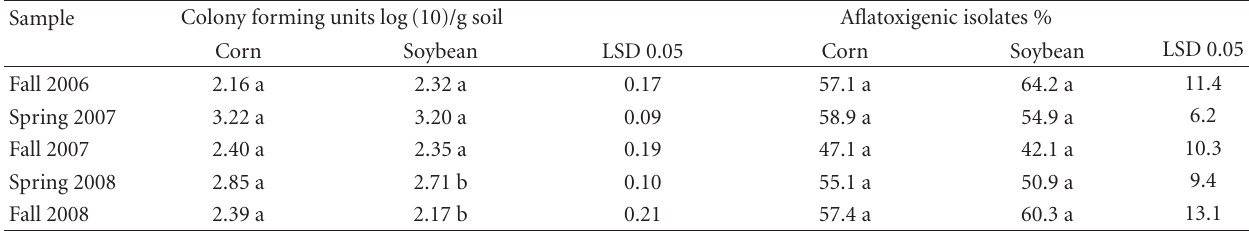
Table 1: E ff ect of previous crop on Aspergillus flavus soil propagules and frequency of toxigenic isolates. 1